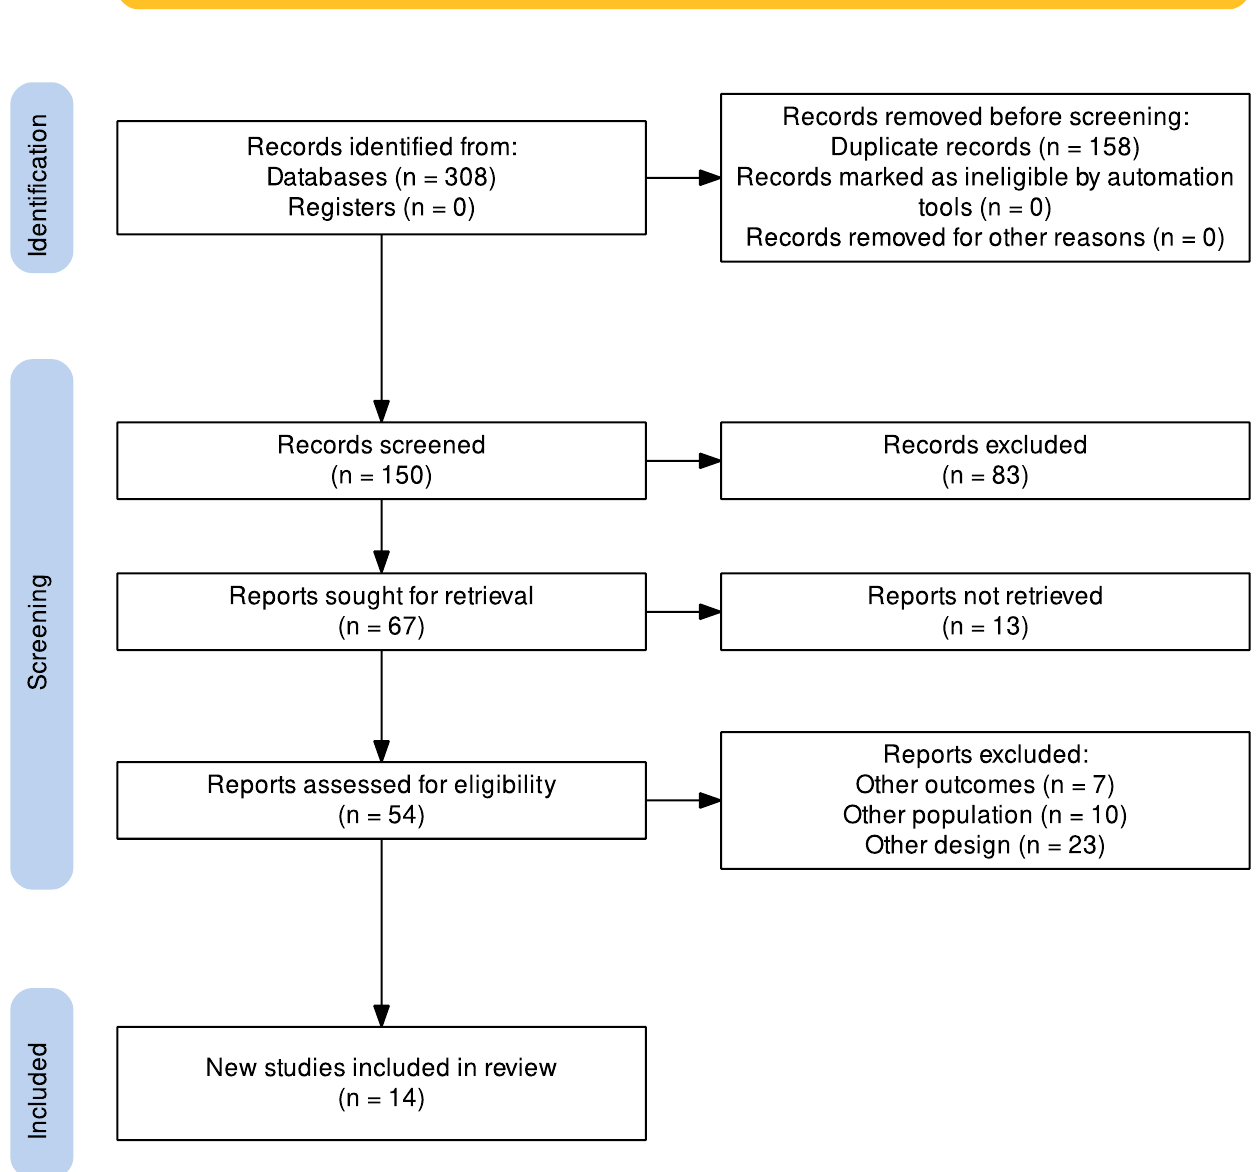
Figure 1. Process for choosing studies, according to the PRISMA flowchart.